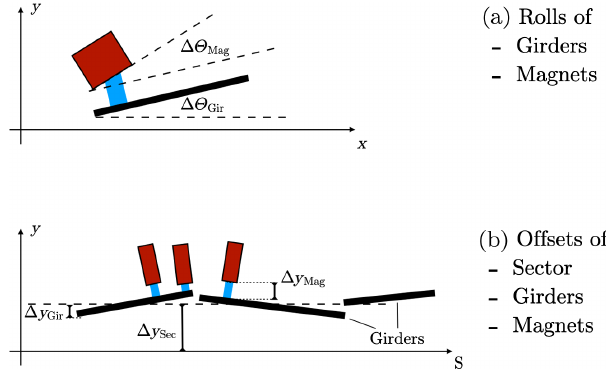
FIG. 2. CAD drawing of a normal arc sector including the four girders (or “ rafts ” ) and their supports. The nine main bends are depicted in blue (B1 type), cyan (B2), and pink (B3). The eight sextupoles are in red. The focusing and defocusing quadrupoles are in green and yellow/light-green, respectively. In the non- normal sectors, normal bends no. 4 and 6 are replaced by permanent-magnet hard bends.